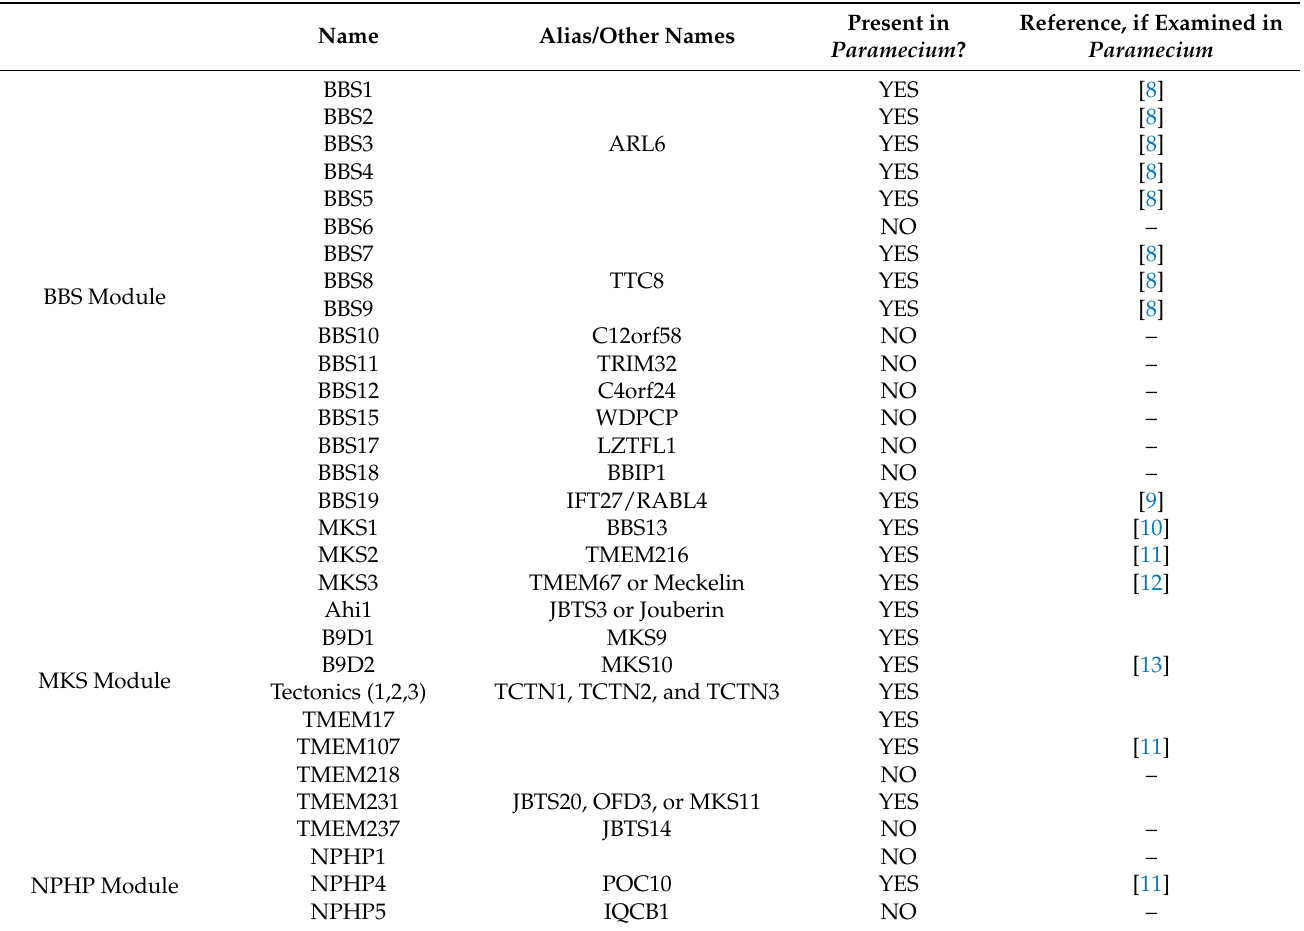
Table 1. Ciliopathy Genes of Paramecium